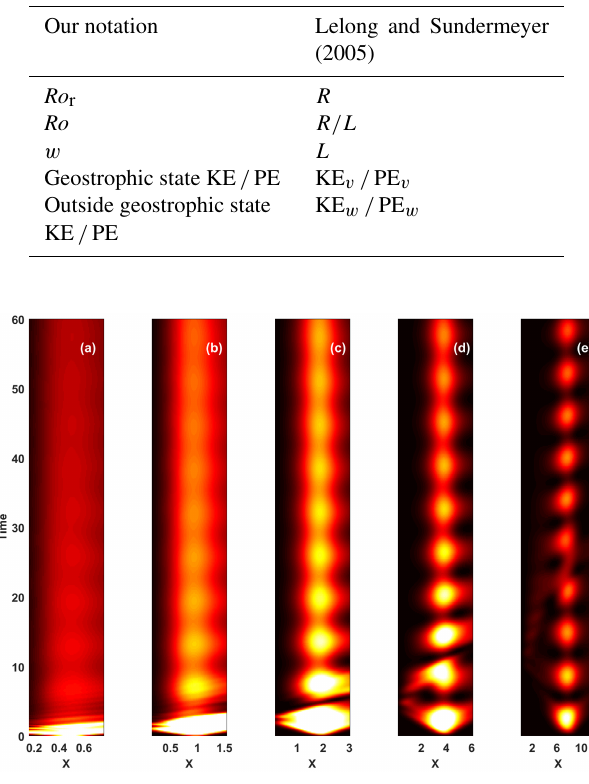
Figure 10. A space–time plot of vertically integrated kinetic energy, in the geostrophic state, for different values of w while f is held w 0 ( Ro = 2), (b) w = 1 w 0 ( Ro = 1), constant at f = f 0 . (a) w = 1 4 2 (c) w = w 0 ( Ro = 0 . 5), (d) w = 2 w 0 ( Ro = 0 . 25), and (e) w = 4 w 0 ( Ro = 0 .